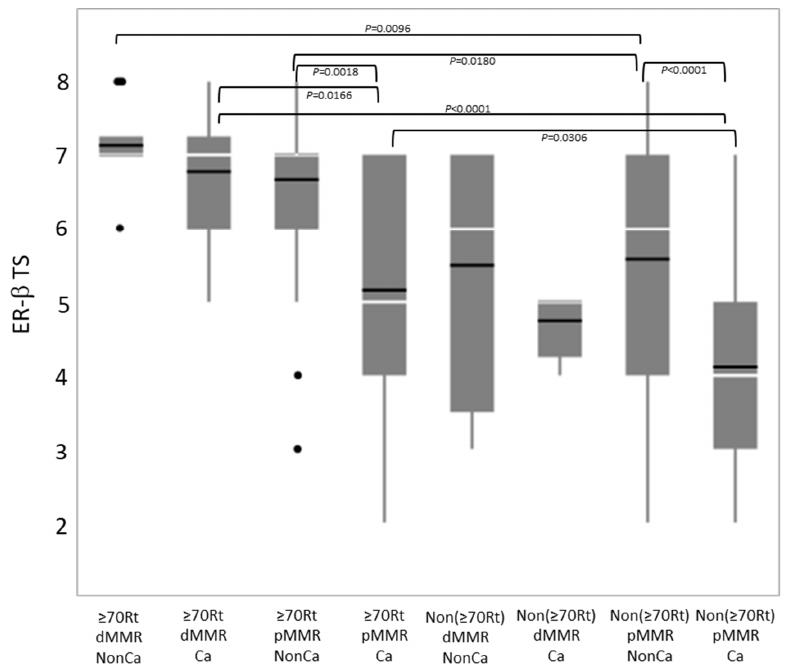
Figure 4. Comparison of immunohistochemical ER- β expression (total score, TS) by boxplot among eight groups categorized by tissue type (Ca vs. NonCa), age/locus ( ≥ 70Rt vs. Non( ≥ 70Rt)), and MMR status (dMMR vs. pMMR). White horizontal bar, median; black horizontal bar, medium. Ca, cancerous tissue; NonCa, non-cancerous tissue; ≥ 70Rt, right-sided case ≥ 70 y/o; Non( ≥ 70Rt), other than ≥ 70Rt; dMMR, mismatch repair protein (MMR)-deficient; pMMR, MMR-proficient.